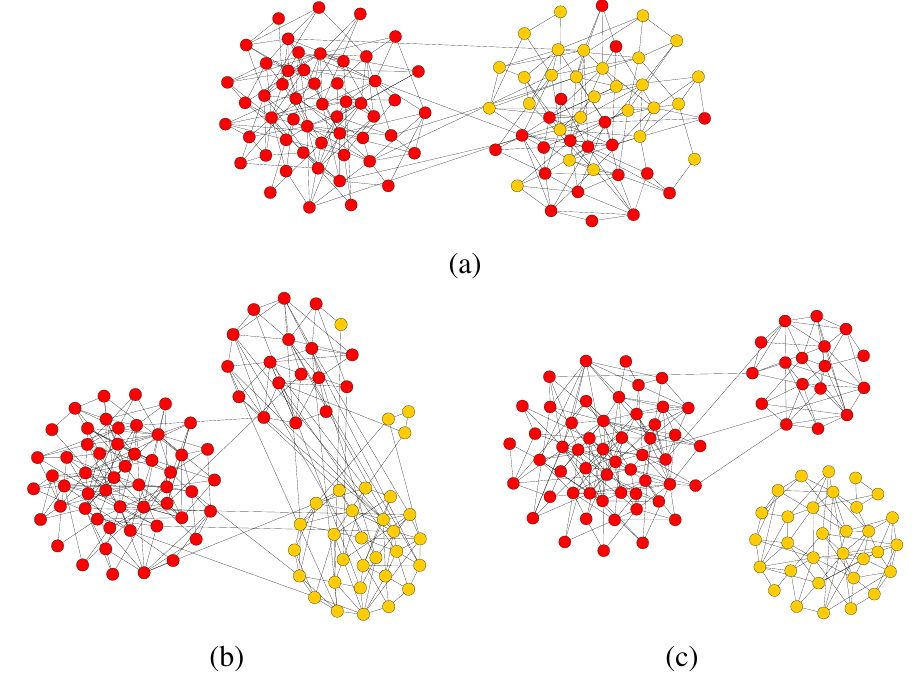
Figure 5. (a) A consistent amount of mutant is inserted in one of the two clusters. (b) This invasion perturbs the structure of the population that starts to reorganize. (c) With enough evolution time the topology reaches a new polarized